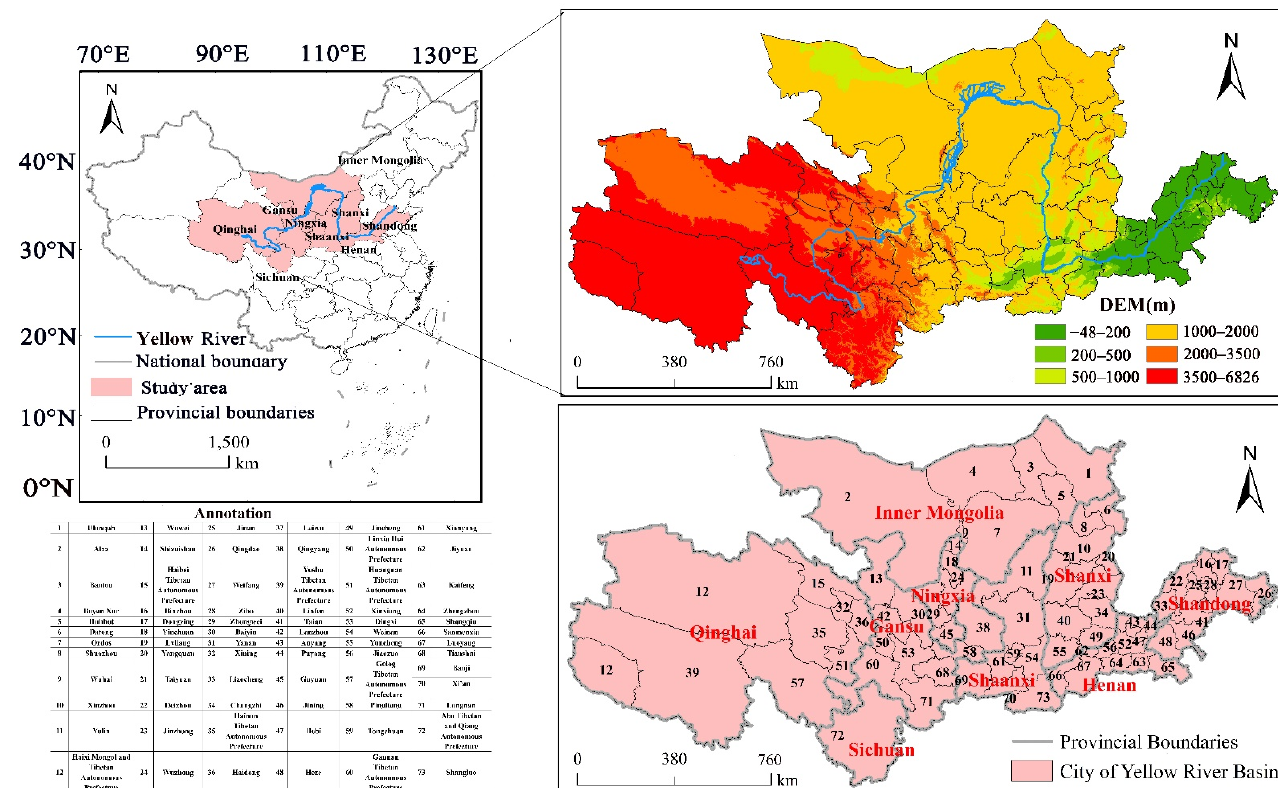
Figure 2. Elevation map of the investigation region.